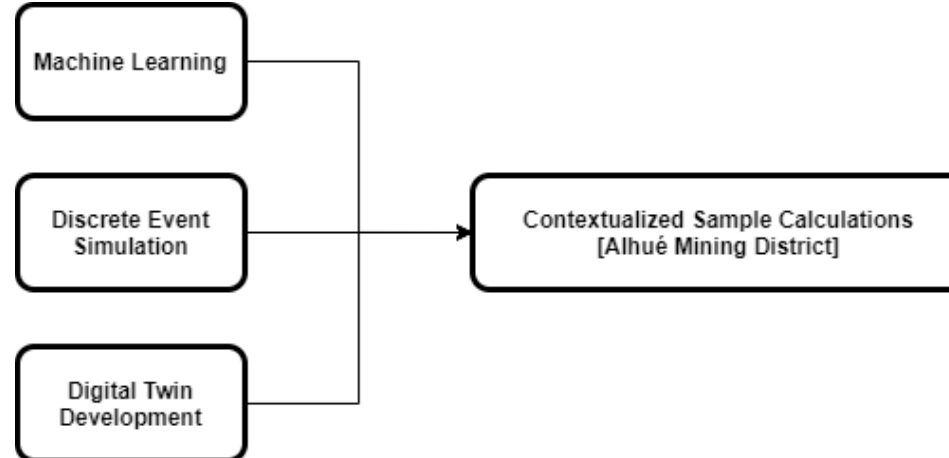
Figure 1. Concepts that were integrated into the contextualized sample calculations.